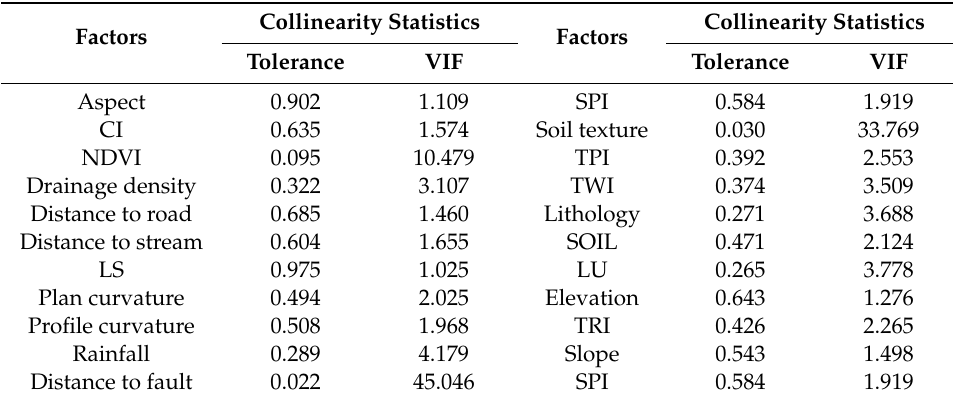
Table 2. Multi-collinearity test among gully erosion conditioning